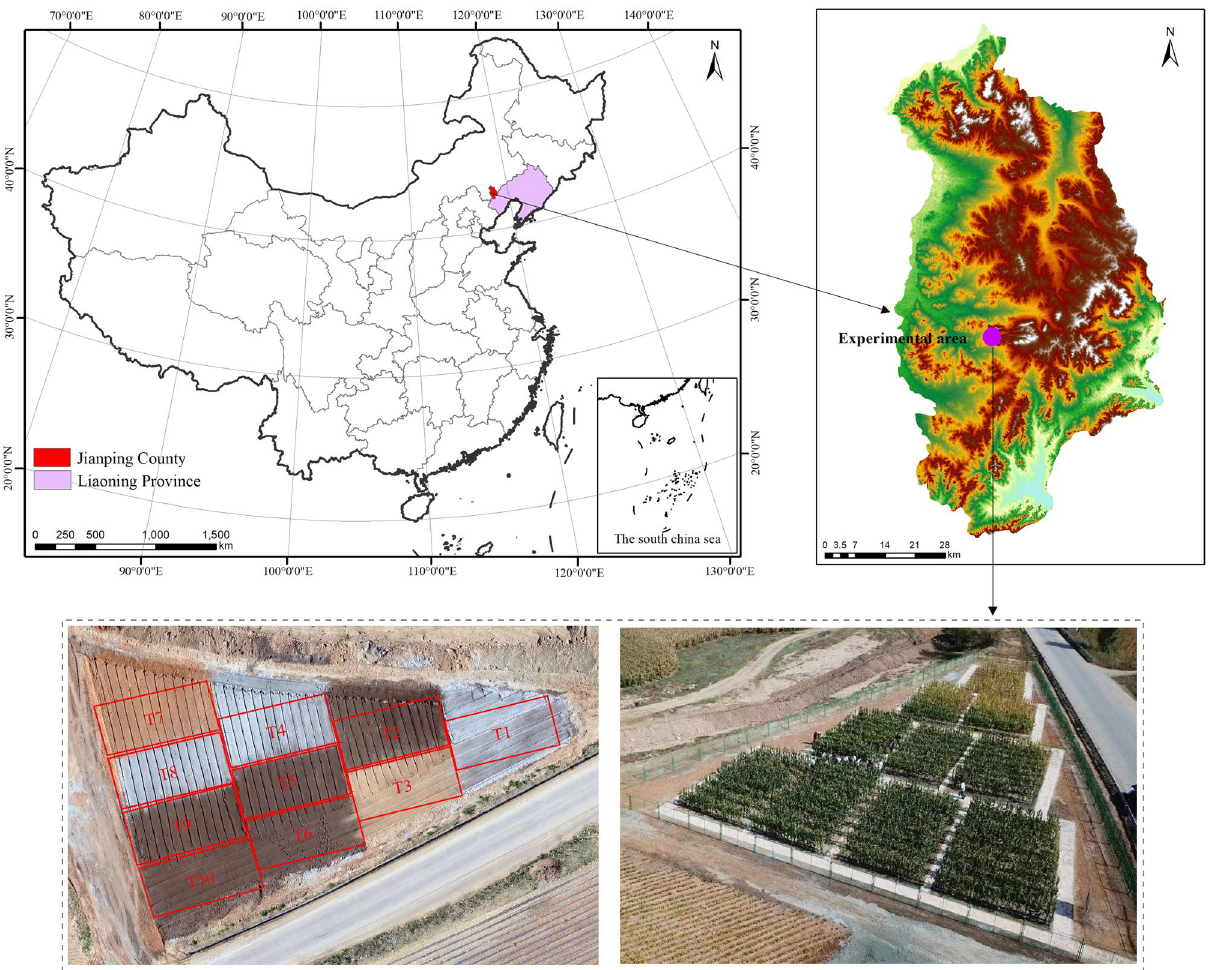
Figure 1. Location of the study area (the red rectangular boxes represent the distribution of the experimental plots of reclaimed farmland. T1 to T10 indicate the ten types of reclamation treatments. The map images were obtained from www. google. com/ maps. The photos of the experimental site were taken during the field